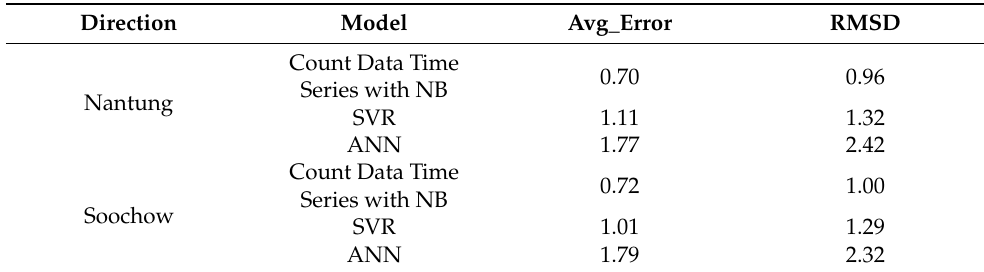
Table 3. Model performance of daily